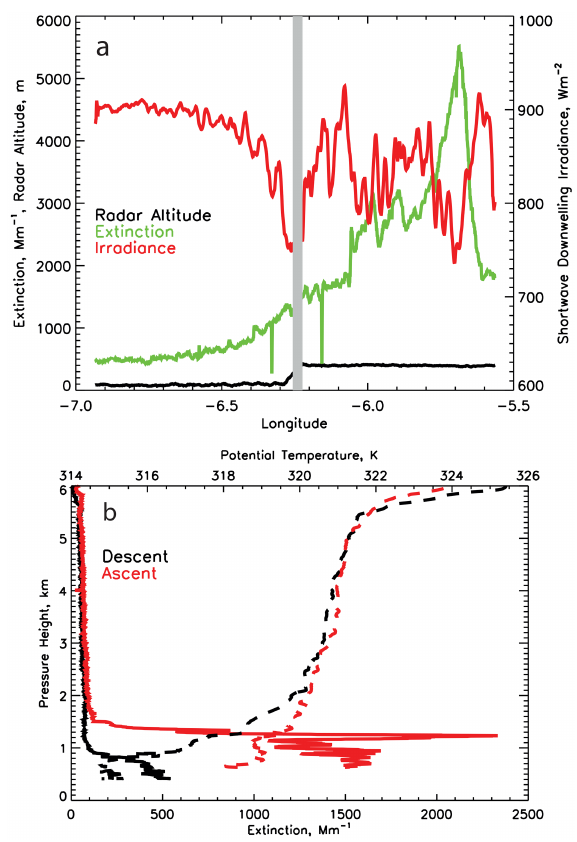
Figure 16. (a) Measurements made during low-level runs in flight b708 on 16 June 2012 sampling uplifted dust by a low-level jet. The black line shows radar altitude (height above ground, left axis), accumulation-mode extinction measured by the nephelometer and PSAP (green line, left axis), and downwelling shortwave irradiance (red line, right axis) measured by a pyranometer, averaged with a moving window of 20s. Grey shading indicates the times when the aircraft ascended due to poor visibility. (b) Profiles of extinction (solid lines) and potential temperature (dashed lines) measured dur- ing flight b708, for the descent (black) and ascent (red). Potential temperature is averaged over 5s